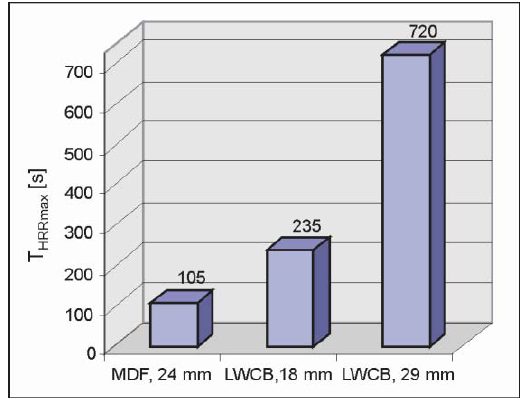
Fig. 8. Mean time to maximal heat release rate (T HRRmax ) when exposed to the surface heat flow density of 30 kW/m 2 for diffe-